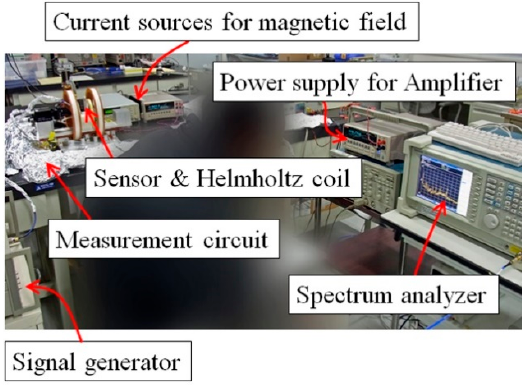
Figure 18. Photograph of whole measurement system.